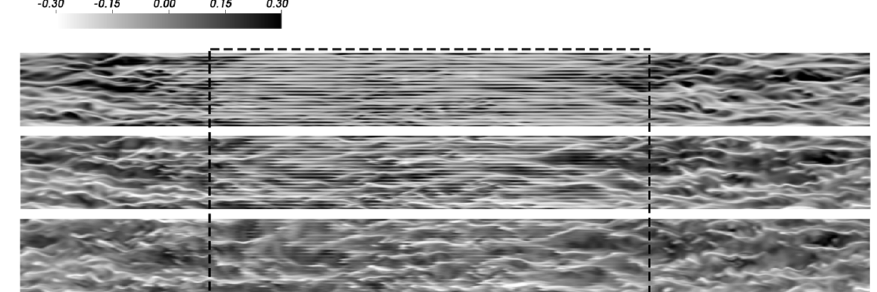
Fig. 12 Fluctuation velocity u’ distribution at three cross-sections. (The top, middle and bottom correspond to y + 8.43, 20.35, 39.22, respectively, and the dashed box is the riblets control =